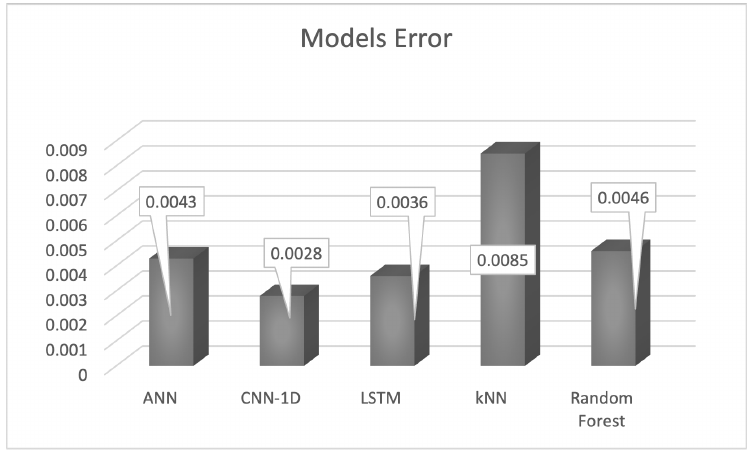
Figure 8. Bar graph illustrating the aptitude obtained by each learning model used in this